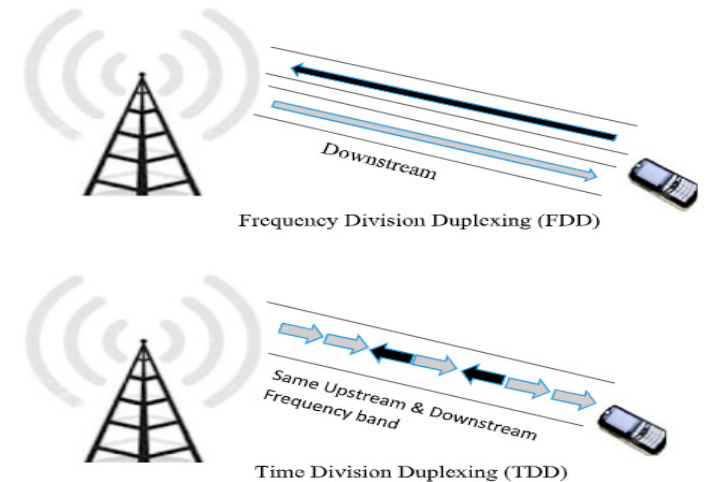
Figure 6. FDD (Frequency Division Duplex) vs. TDD (Time Division Duplex).